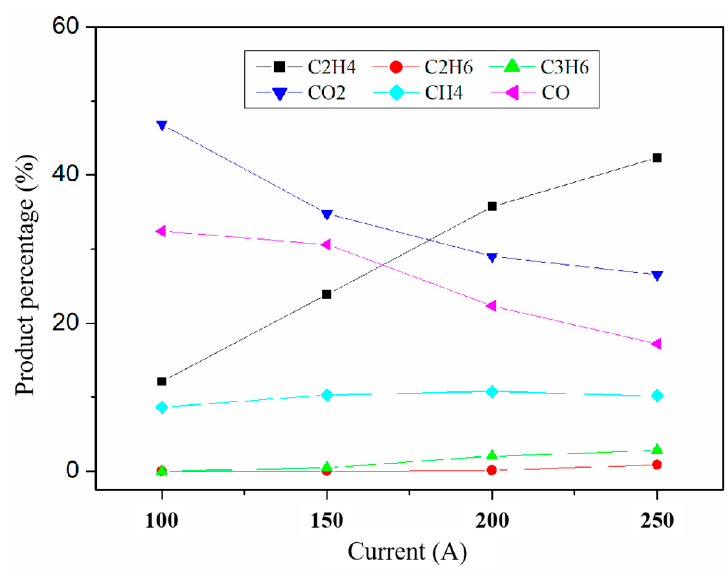
Figure 7. Effect of current on the percentage of the gas